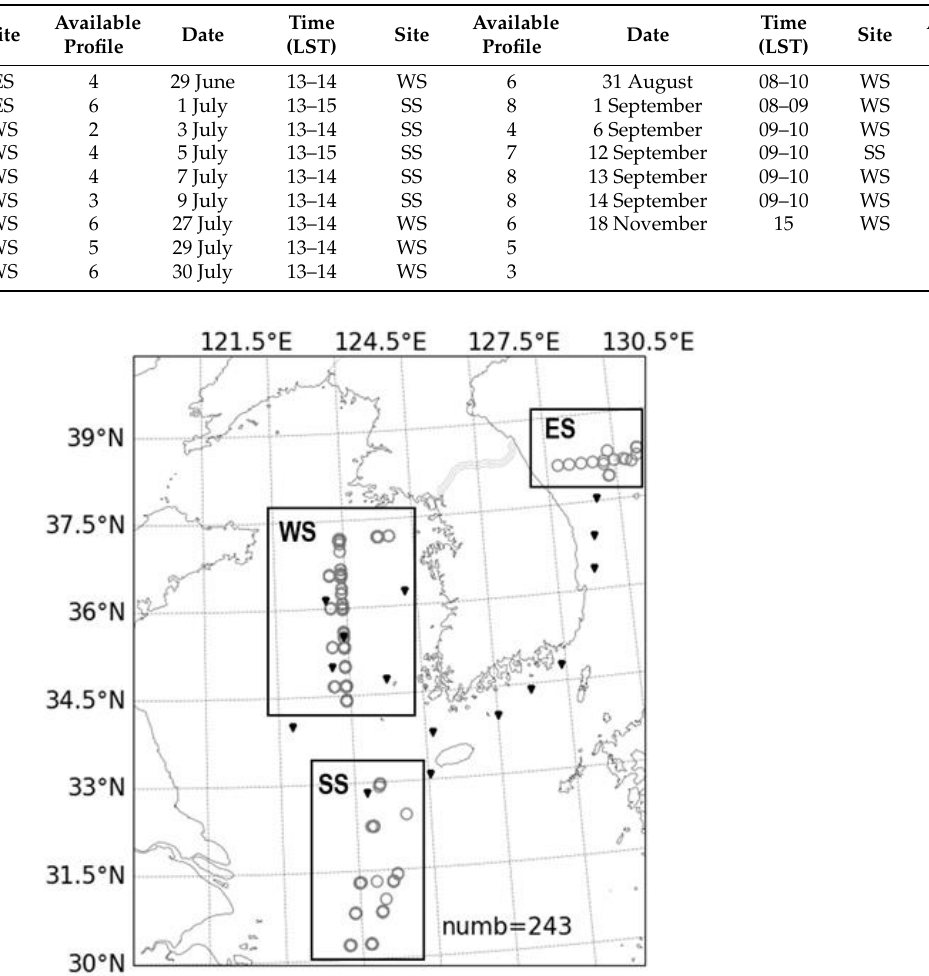
Figure 1. Location of dropsondes release zones (gray circles) in the WS, ES, and SS of the Korea and buoy positions (black triangles).